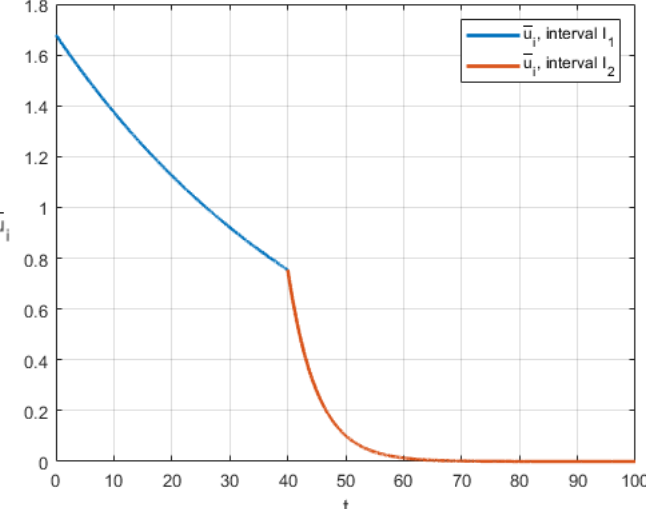
Figure 2. Optimal control in the case of time-dependent